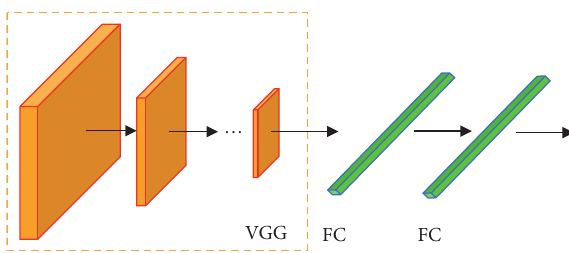
Figure 3: The APN architecture. APN contains pretrained VGG-19 and two-stacked fully connected